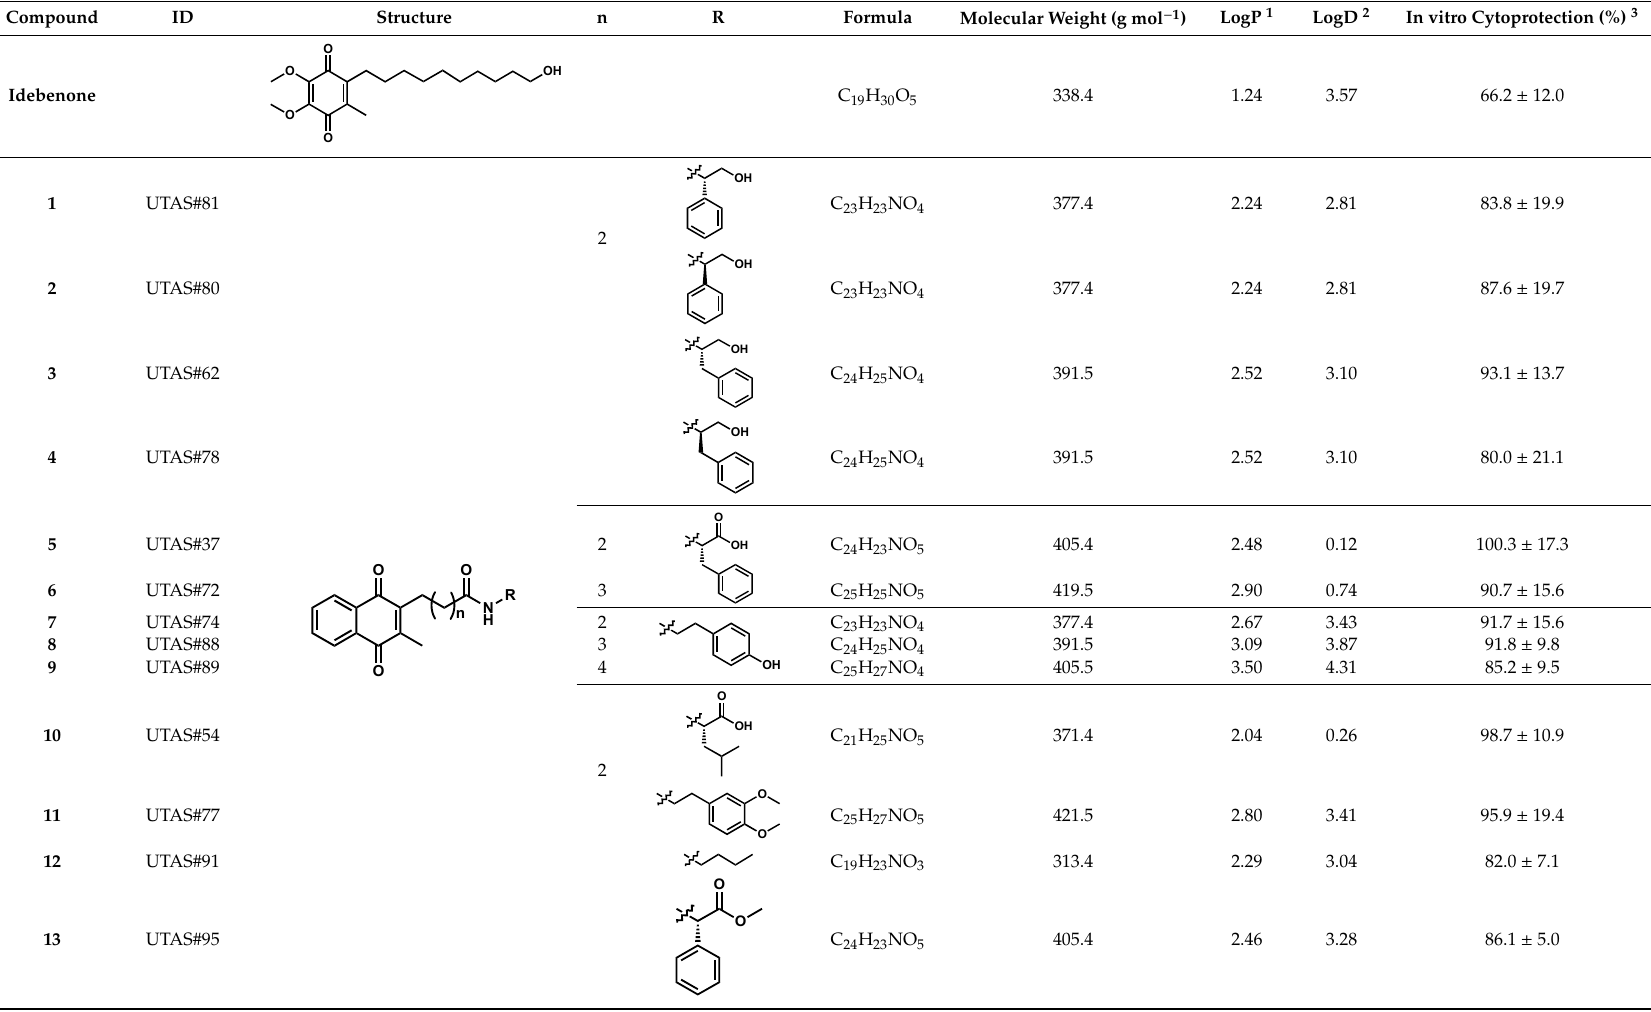
Table 1. Chemical structure, physical properties and in vitro efficacy of 16 novel short-chain quinones (SCQs) and the reference compound idebenone. Compound